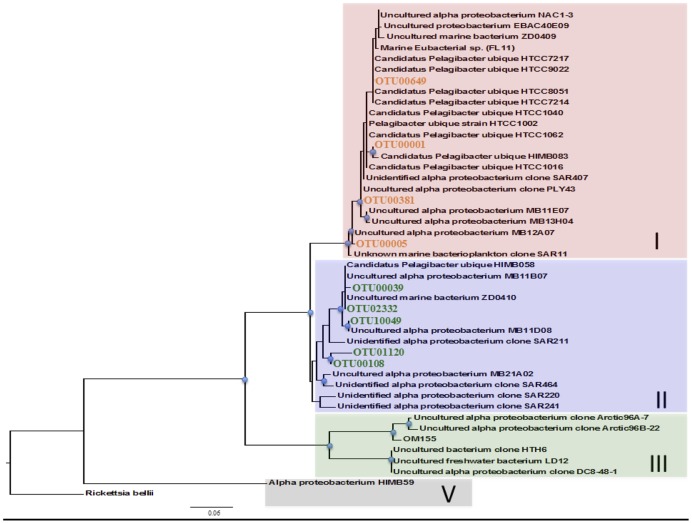
Phylogenetic divide among SAR11 OTUs with respect to nitrate uptake. Maximum-likelihood 16S rRNA phylogenetic tree of SAR11 OTUs from the nitrate treatment using PHYML (PHYlogenetic inferences using Maximum-Likelihood) with 1000 bootstraps. OTUs identified as assimilators (orange text) are all found within subclade I whereas those without isotopic enrichment (green text) resided within subclade II. Phylogenetic clade/ecotype designated at the right. The scale bar represents 0.06 substitutions per site. Blue nodes indicate bootstrap values greater than 50. Rickettsia bellii was used as the outgroup.